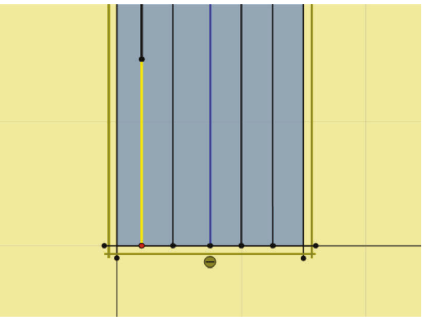
Figure 12: Interface extended beyond the boundaries of the pile cluster.